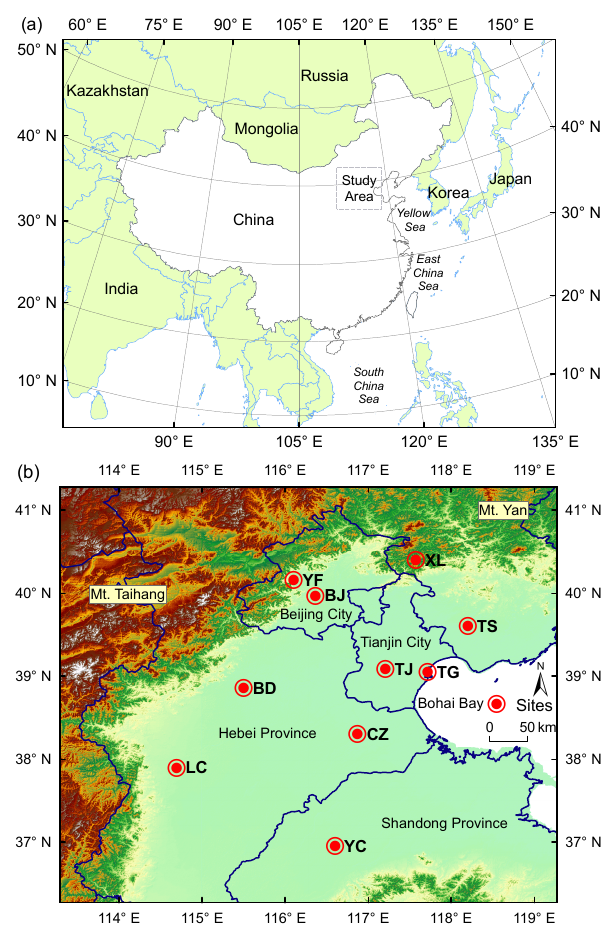
Fig. 1. Locations of the study area and the sampling sites in North- ern China. Of the ten selected sites, two mega city sites are lo- cated in the Beijing (BJ, 39.96 ◦ N, 116.36 ◦ E) and Tianjin (TJ, 39.08 ◦ N, 117.21 ◦ E) downtown areas; two suburban sites 2km southeast of Cangzhou city (CZ, 38.30 ◦ N, 116.87 ◦ E) and at Yang- fang (YF, 40.15 ◦ N, 116.10 ◦ E), which is 40km northwest of Bei- jing city; three industrial city sites in the center of Baoding city (BD, 38.85 ◦ N, 115.50 ◦ E), south of Tangshan city (TS, 39.60 ◦ N, 118.20 ◦ E) and in the coastal Tanggu (TG, 39.04 ◦ N, 117.72 ◦ E) area, which is 30km east of Tianjin city; two agricultural sites 6km southwest of Yucheng city (YC, 36.85 ◦ N, 116.55 ◦ E) and at Luancheng (LC, 37.89 ◦ N, 114.69 ◦ E), which is 4km southeast of Shijiazhuang city; and one rural site at Xinglong (XL, 40.38 ◦ N, 117.57 ◦ E) on Mt. Yan, with an elevation of